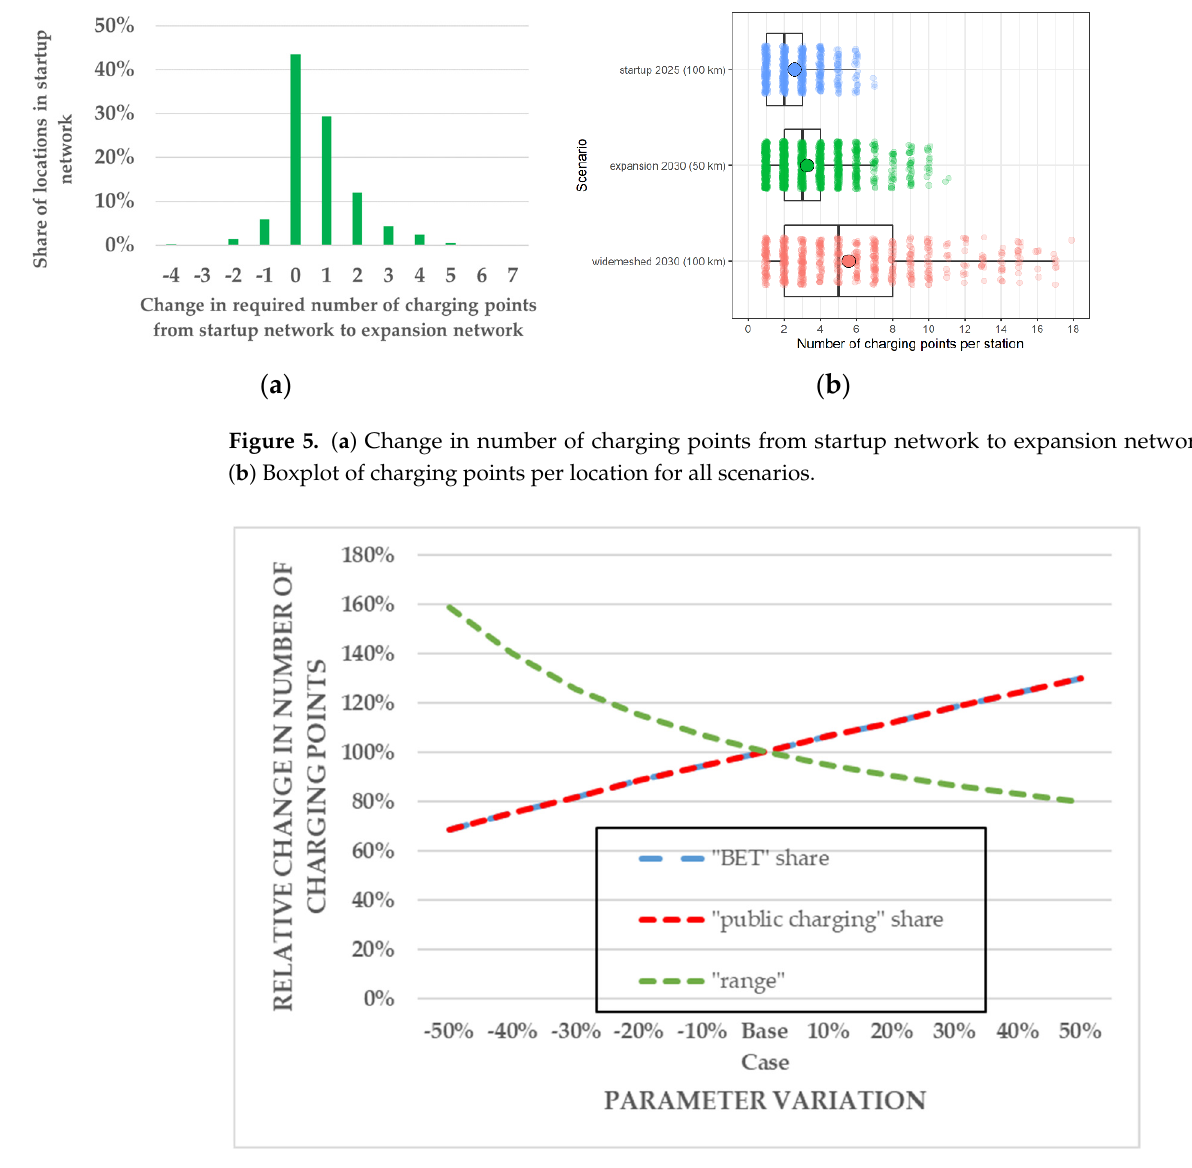
Figure 6. Sensitivity analysis for the expansion